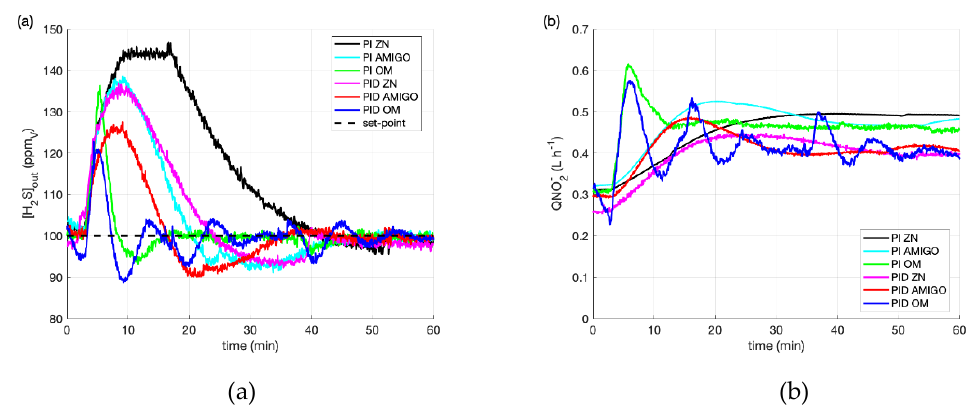
Figure 2. Controller selection: ( a ) outlet H 2 S concentration for PI and PID controllers; ( b ) nitrate flow rate (controlled variable) for PI and PID controllers. Table 4. Integral errors for PI and PID controllers.